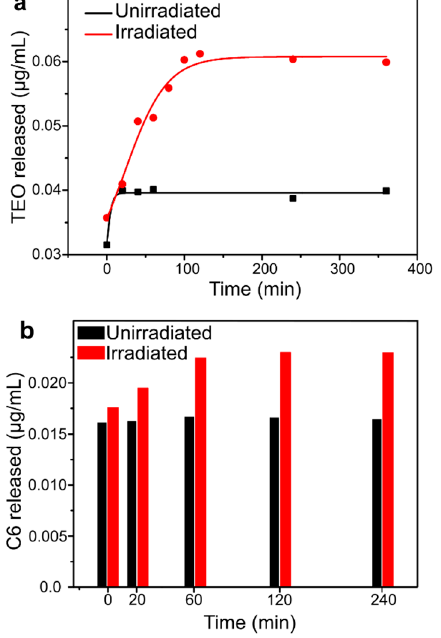
Figure 5. Release kinetics of TEO ( a ) and C6 ( b ) from MAPLE-deposited NC.